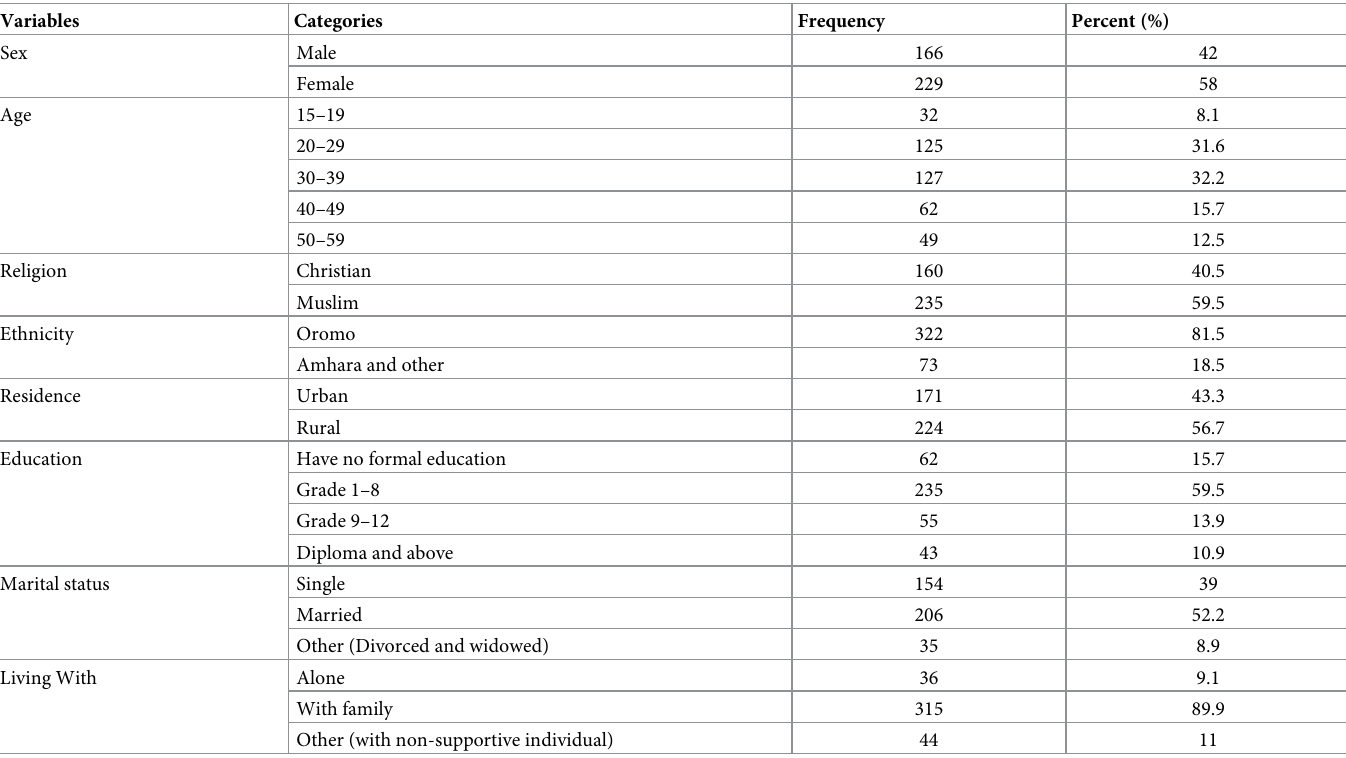
Table 1. Frequency distribution of respondents by socio demographic and economic factors in Asella Referral and Teaching Hospital 2022.